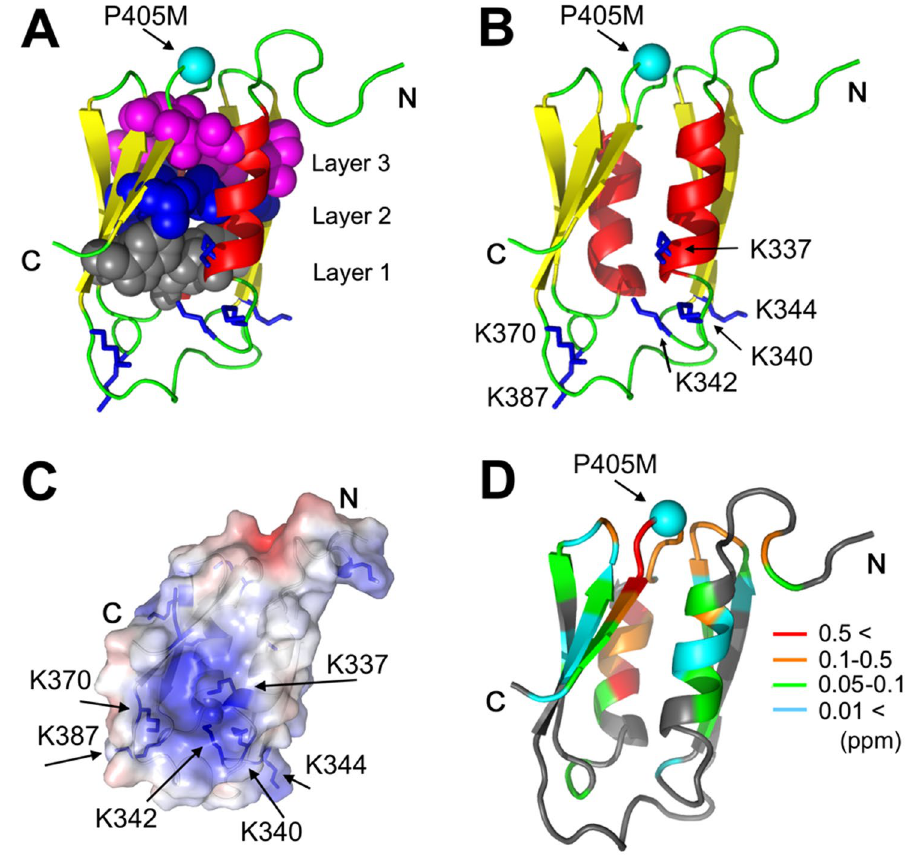
Figure 2. Structural properties of the HlyIIC domain. ( A ) Cartoon of the HlyIIC NMR structure closest to the ensemble average, illustrating the 3-layer hydrophobic core of HlyIIC. ( B ) The relationship between P405, which is subject to cis/trans isomerization in WT-HlyIIC and a patch of positively charged lysine residues at the bottom of the structure. ( C ) Electrostatic surface of HlyIIC calculated using the APBS method 32 , showing the positively charged patch formed by basic lysine residues. ( D ) Structural mapping of chemical shift differences between the conformational states of WT-HlyIIC related by cis/trans isomerization of P405. The composite (| ∆ HN| + 0.1| ∆ N|) chemical shift index data 25 are colored on a gradient running from cyan for the smallest differences to red for the largest. Residues that do not show splitting of 1 H- 15 N resonances due to cis / trans isomerization are in